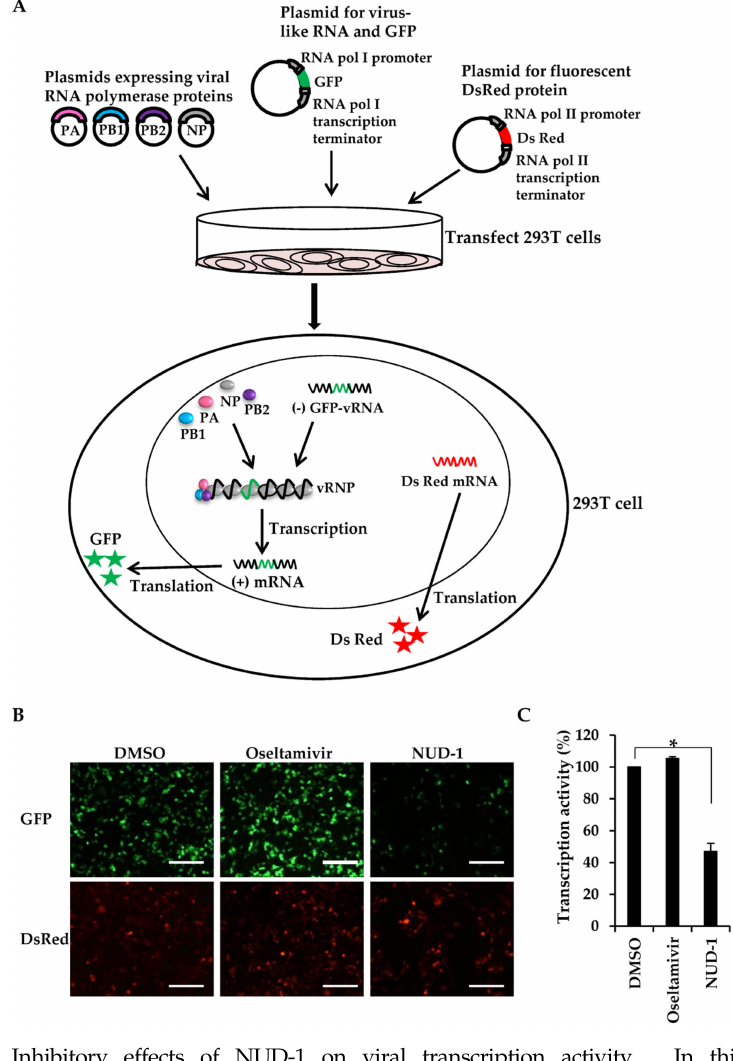
Figure 2. Inhibitory effects of NUD-1 on viral transcription activity. In this experiment, 293T cells were co-transfected with the viral protein expression plasmids (pCAGGS-PA-WSN, pCAGGS-PB1-WSN, pCAGGS-PB2-WSN, and pCAGGS-NP-WSN), the model viral genome expression plasmid (pPolI / NP(0)GFP(0)), and the control plasmid pDsRed2-monomer-N1. Two hours